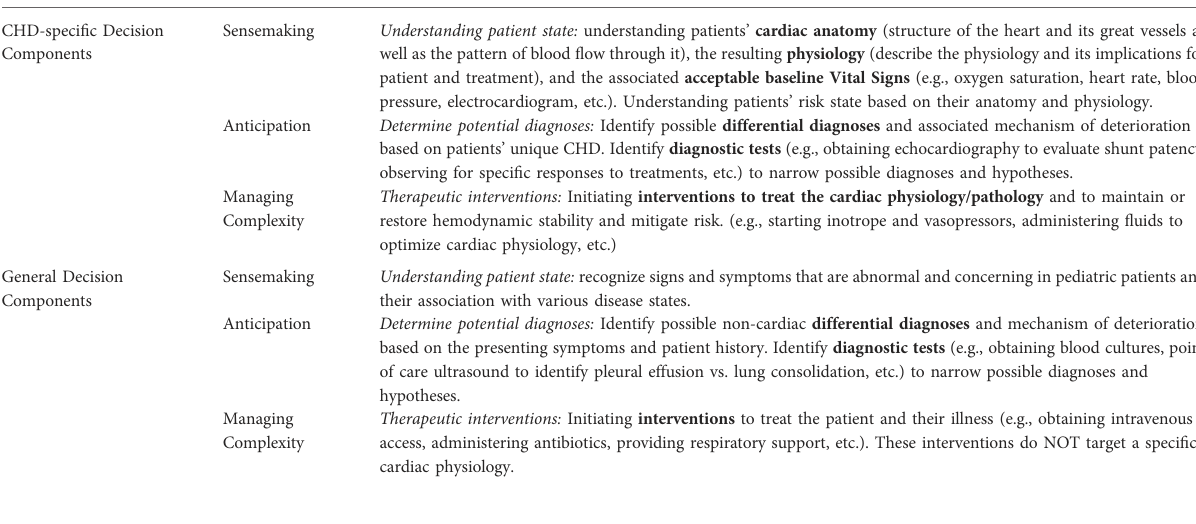
TABLE 2 Analytical